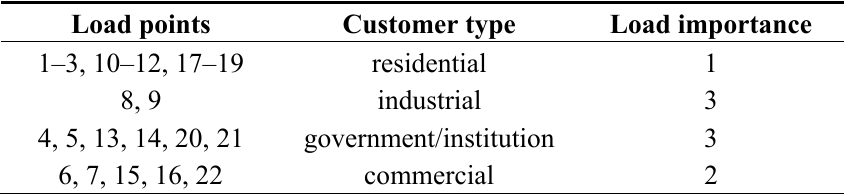
Table 2. The importance of different